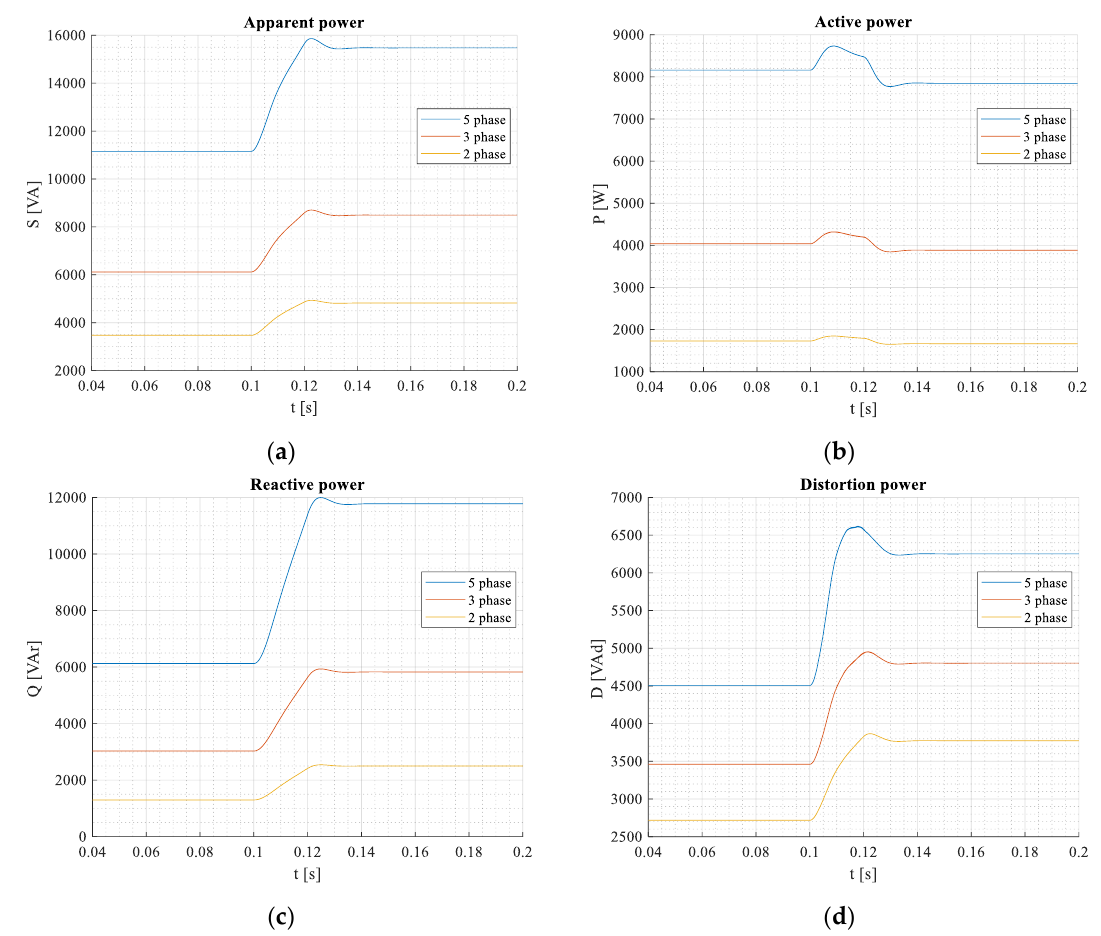
Figure 25. Apparent — ( a ), active — ( b ), blind — ( c ), and distortion ( d ) power components during tran- Figure 25. Apparent—( a ), active—( b ), blind—( c ), and distortion ( d ) power components sient states for 3-, 5-, and 2-phase systems under inverter-supplied linear RL load.